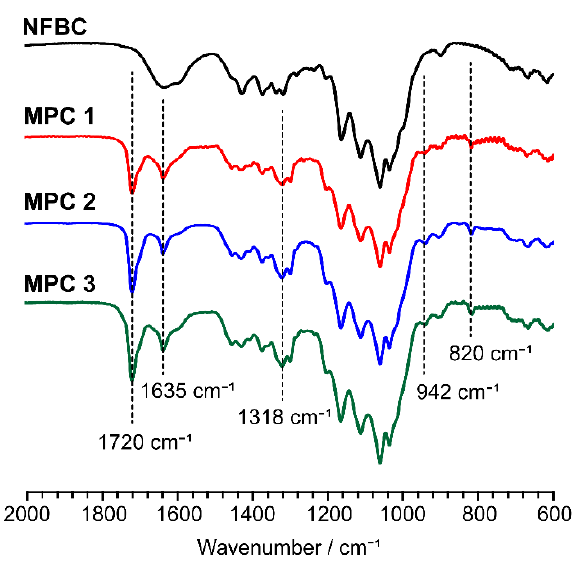
Figure 1. Fourier transform infrared (FTIR) spectra of MPC 1–3 and NFBC.